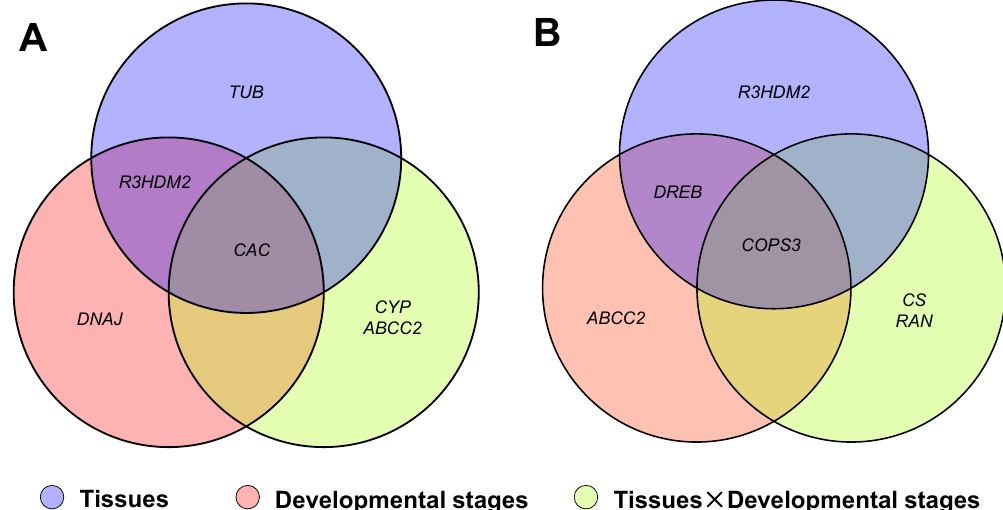
Figure 3. Stability of candidate reference genes under different conditions in G.urelensis and G. inflata . The top three most suited reference genes under different experimental conditions in G. uralensis (A) and G. inflata